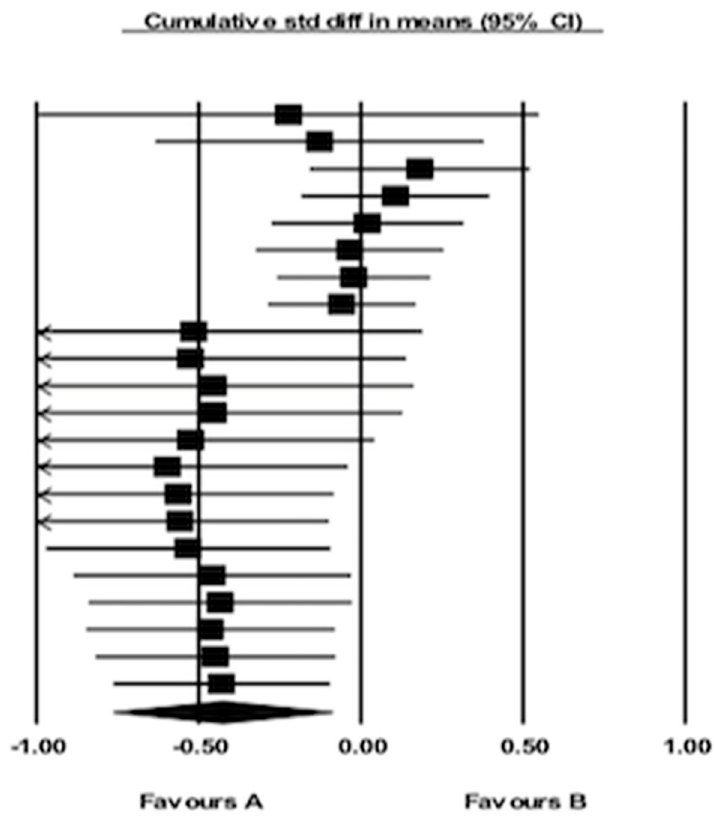
Figure 2. Forest plot for BMI z-scores.